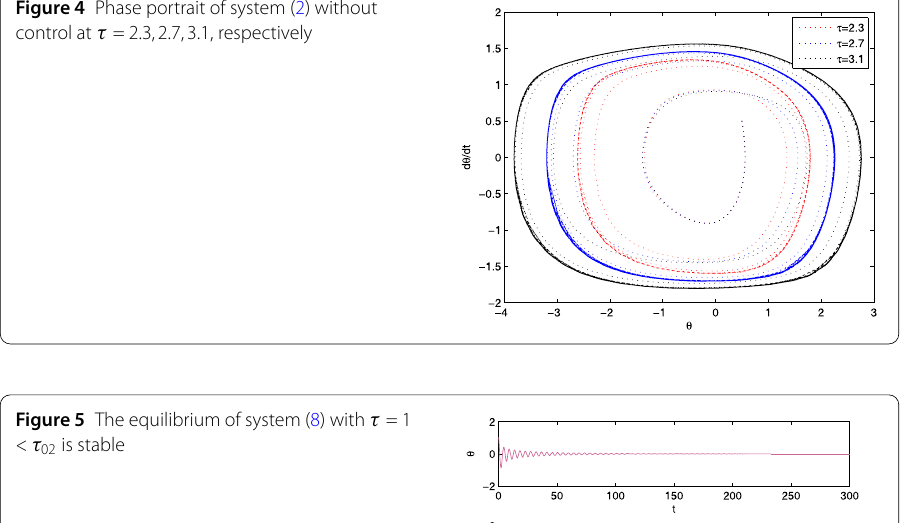
Figure 5 The equilibrium of system (8) with τ = 1 < τ